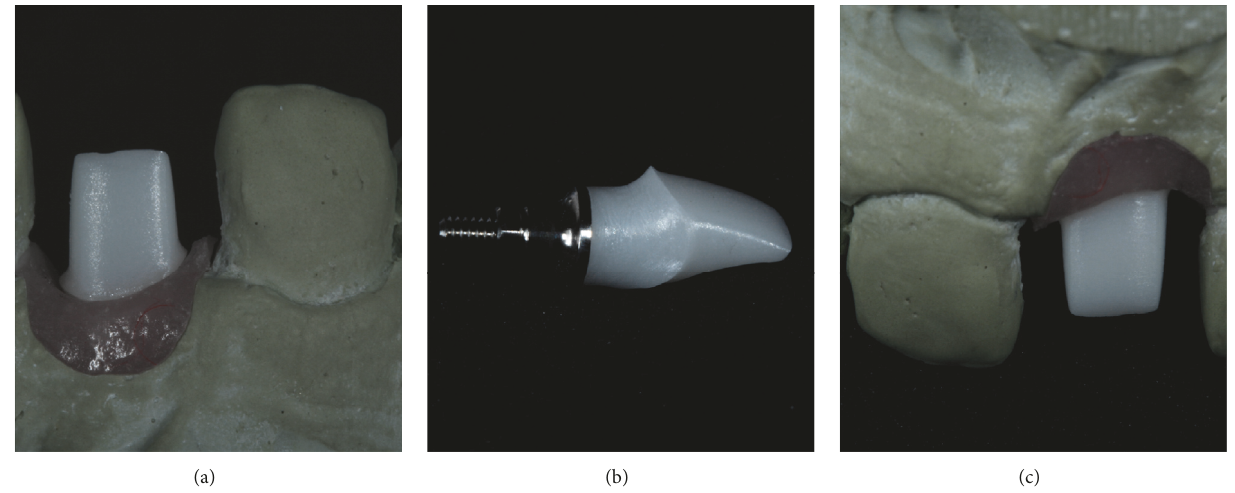
Figure 9: After the osseointegration period, an impression of the implant was taken to fabricate a customized zirconia abutment with a subgingival concave contour (a–c).